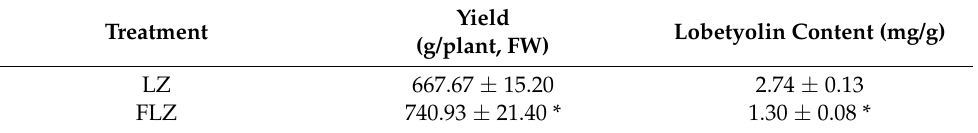
Table 1. Comparison of yield and Lobetyolin content between main cropping (FLZ) and continuous cropping (LZ).